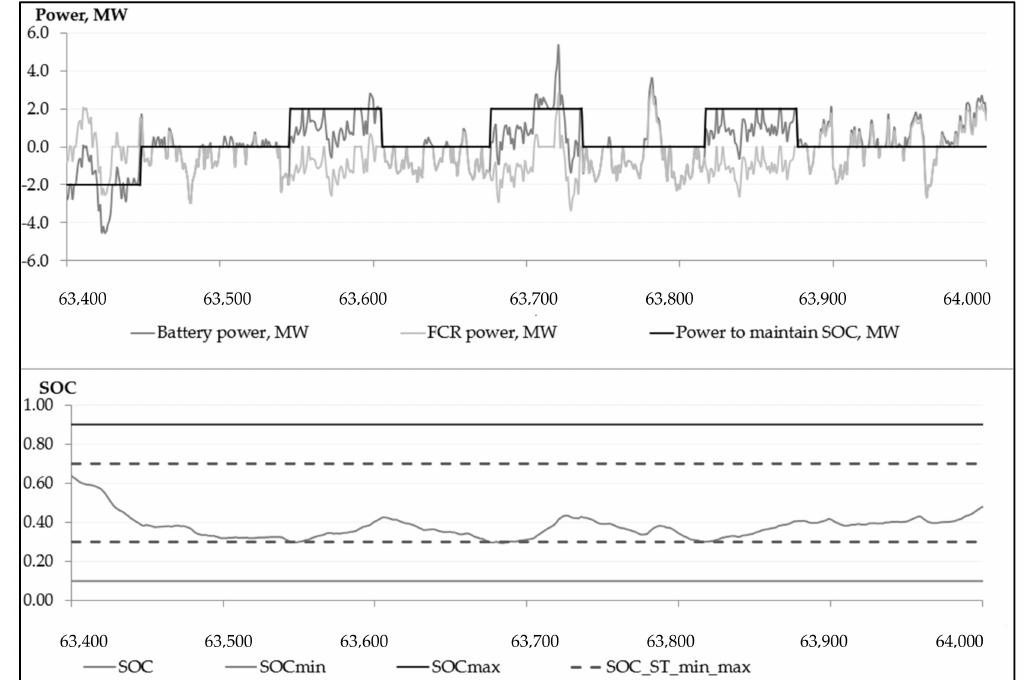
Figure 11. Dynamics of battery power and state of charge in the example of the French power system (II quarter, 15.05.19 at